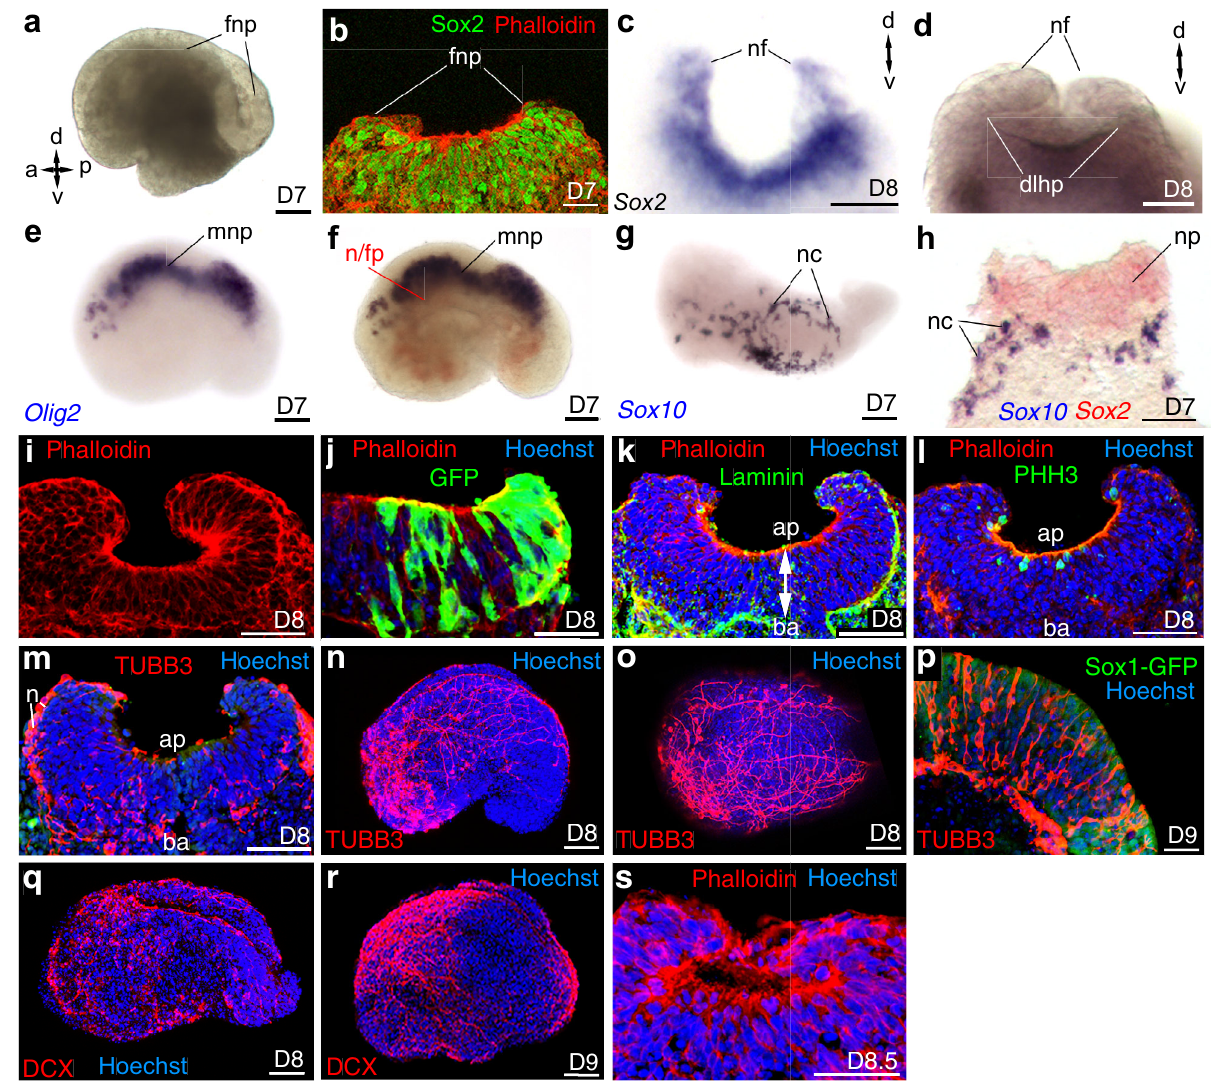
Fig. 6 Characterization of the neural plate and formation of the neural tube. a – c Folding of the neural plate (fnp), nf: neural fold. AP and DV axes are indicated. b , c Expression of Sox2 seen by b immunostaining (number embryoid N = 4/4), c in situ hybridization ( N = 2/2) on transverse section. d Front view of an embryoid showing the folded neural plate closing into a neural tube, dorso-lateral hinge points (dlhp). e – h Single or double colour in situ hybridization for e Olig2 revealing motor neuron progenitor (mnp). f Shh (red) in the notochord and fl oor plate (n/fp) in a territory immediately ventral to Olig2 (blue) expression domain. g , h Expression of Sox10 revealing the neural crest cells (nc) in dorsal view ( N = 2). h Transverse section of an embryoid after double colour in situ hybridization for Sox2 (red — neural plate) and Sox10 (blue — neural crest cells). i – m Transverse sections of a folding neural plate ( N = 9/9). j The organization of a pseudostrati fi ed columnar epithelium. Green: GFP cells extending from the apical to the basal side of the epithelium ( N = 3/3) k apical (ap) – basal (ba) polarity of the epithelium with apical accumulation of actin labelled with Phalloidin and basal accumulation of laminin ( N = 3/3). l Immunolabelling for Phospho-Histone H3 (PHH3) revealing that cell divisions occur at the apical side of the epithelium (number of embryoids N = 3/3, number of mitotic cells at the apical side N = 7/8). m Immunolabelling revealing the presence of neuronal cell bodies (n) expressing TUBB3 at the basal side of the neural plate ( N = 3/3). n , o Expression of TUBB3 (red) showing neurons extending their axons in the neural plate and toward the non- neural part of the embryoids ( n , lateral view; o , dorsal view of the same embryoid). p TUBB3 expressing neurons (red) in multiple layers of the anterior neural plate in a parasagittal section at D9 ( Sox1-GFP , green) ( N = 2/2). q , r Expression of DCX (red) con fi rming the presence of neurons and axons extending both within the neural plate and toward the non-neural part of the embryoids ( N = 4/4). s Neural plate closed into a neural tube ( N = 2/8). g – s Hoechst is labelling the nuclei. Developmental stages of the embryoids and drawing of embryos bottom right of each panel. Scale bars: 100 µ m. Numbers of performed experiments of biological samples analysed and variability in genes expression are provided in Supplementary Fig. 14. NATURE COMMUNICATIONS| (2021) 12:3277